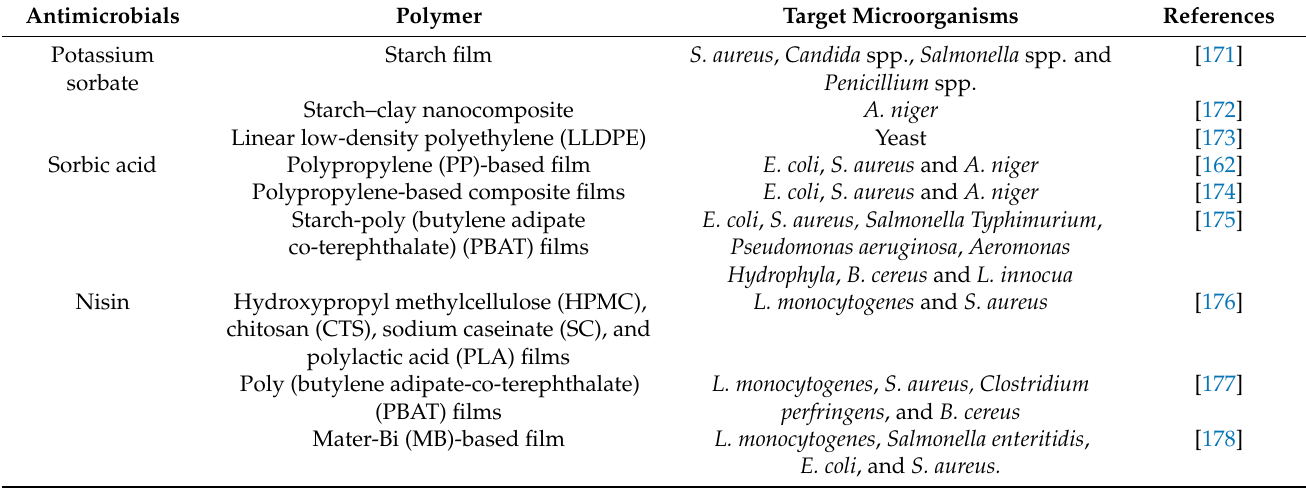
Table 3. Summary of selected studies on antimicrobials incorporated into polymers.